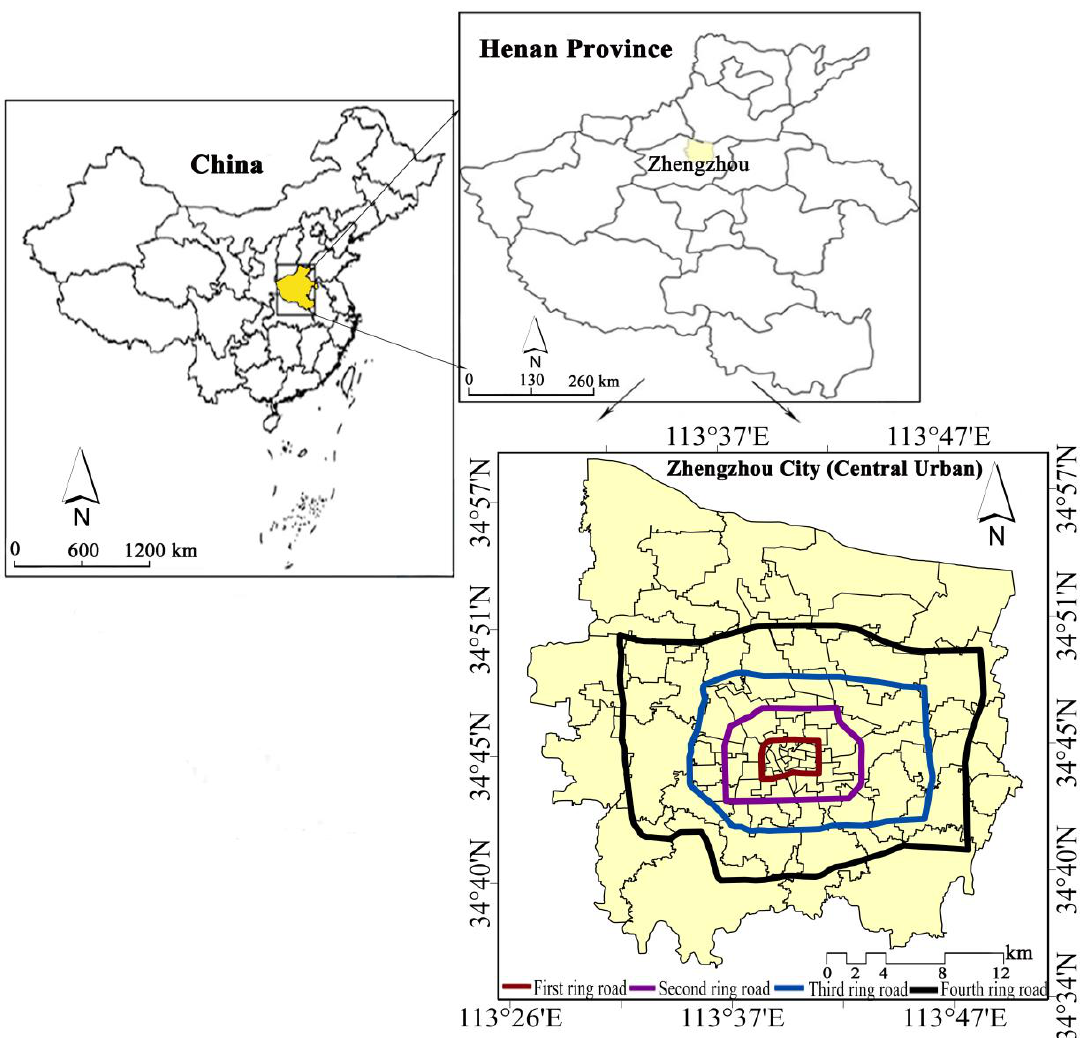
Figure 1. The location of Zhengzhou City in Henan Province, China (the four traffic rings around the downtown area are